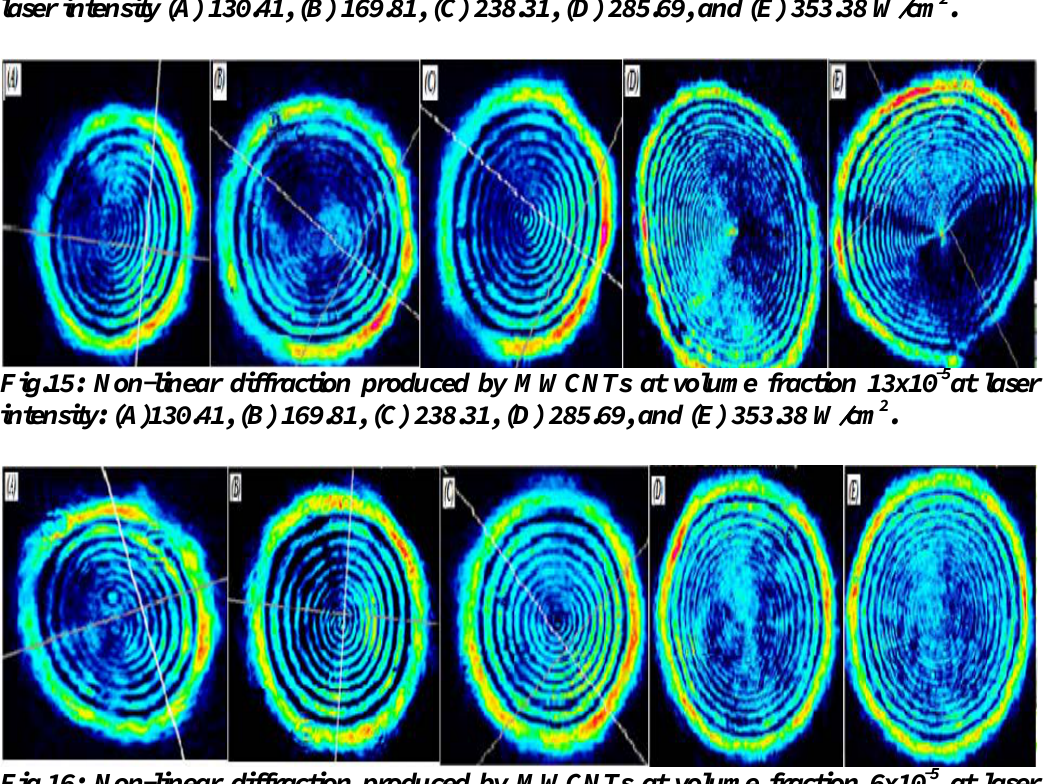
Fig.16: Non-linear diffraction produced by MWCNTs at volume fraction 6x10 -5 at laser intensity: (A) 130.41, (B) 169.81, (C) 238.31, (D) 285.69, and (E) 353.38 W / cm 2